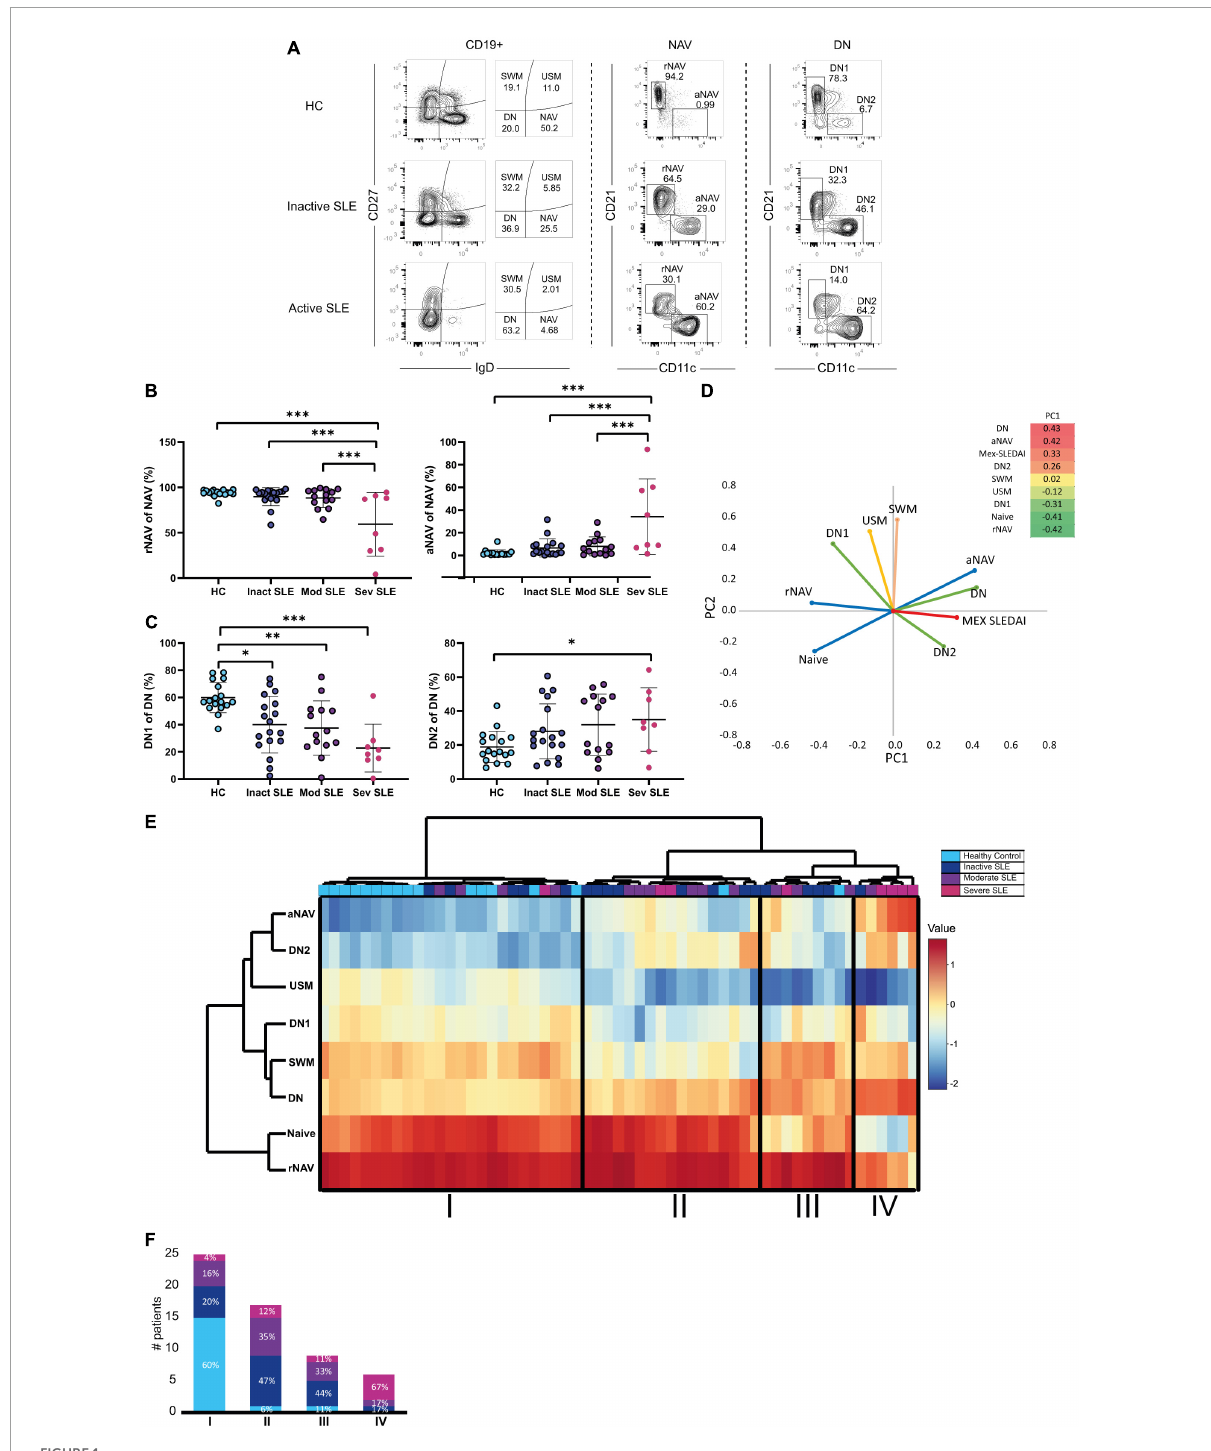
FIGURE1 B cell subsets and disease activity. (A) Gating strategy for B cell subsets analysis. Mex-SLEDAI scores for an inactive patient were 3, and 9 for an active patient. (B) Active (aNAV) and resting (rNAV) B cells in Healthy Controls (clear blue), Inactive (dark blue), Moderate (purple), and Severe (dark pink) active SLE patients. Multivariate Analysis of Variance (MANOVA) was used for analysis and means, and SD are depicted in the figures. (C) DN1 and DN2 cells in Healthy Controls (clear blue), Inactive (dark blue), Moderate (purple), and Severe (dark pink) active SLE patients. Multivariate Analysis of Variance (MANOVA) were used for analysis and means, and SD are depicted in the figures. (D) Principal Component Analysis of B cell subsets. (E) Hierarchical cluster analysis of B cell subpopulations. (F) Percentage of patients with severe activity, moderate activity, inactive and healthy controls in each detected cluster. * P ≤ 0.05; ** P ≤ 0.01; *** P ≤